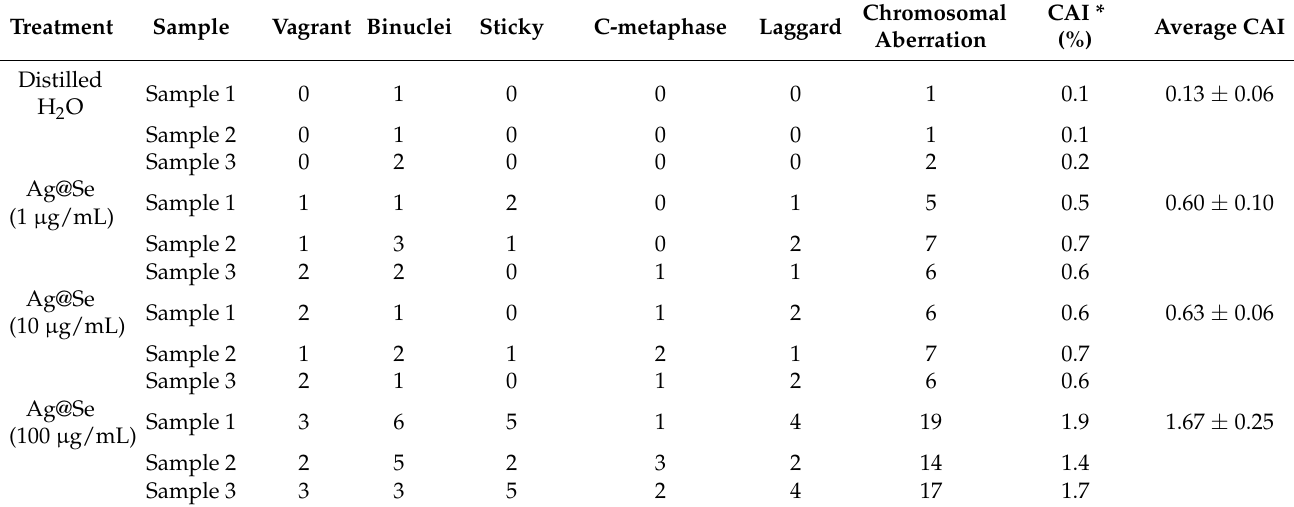
Table 5. Mitotic division rate per 1000 cells scored in control and Ag@Se NP treated Allium cepa root cells. Treatment